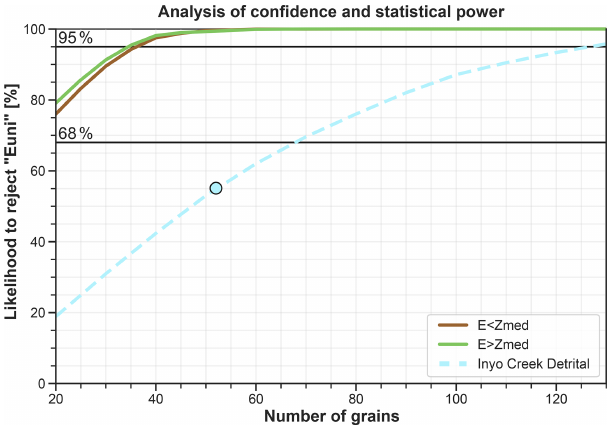
Figure 7. Confidence level at which the observed CAD ( n = 52) can be discerned from the uniform erosion prediction (cyan circle). The dashed cyan line shows how the allowed confidence level would vary if the same observed CAD relied on 20–130 grain ages. Statis- tical power of discerning the tested erosion scenarios from “ E uni ” as function of sample size (solid lines). In this case study, the ob- served CAD of the Inyo Creek detrital sample allows rejecting the uniform erosion hypothesis with 55% confidence at best. An anal- ysis to detect the scenarios “ E < Z med ” and “ E > Z med ” would have a statistical power greater than 95% in rejecting “ E uni ” with more than 37 grain ages. E uni indicates uniform erosion, E < Z med indicates 10-fold erosion below median elevation, and E > Z med indicates 10-fold erosion above median